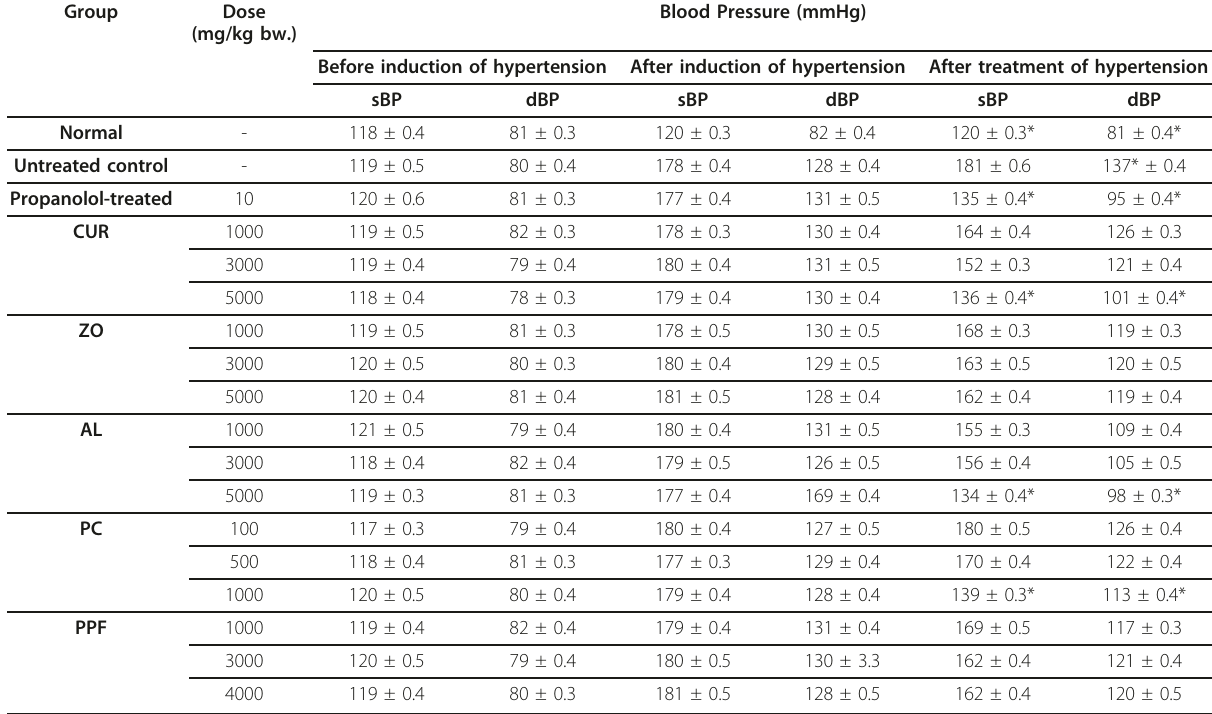
Table 2 Effect of test materials and propanolol on systolic (sBP) and diastolic (dBP) blood pressure of rats Group Dose (mg/kg